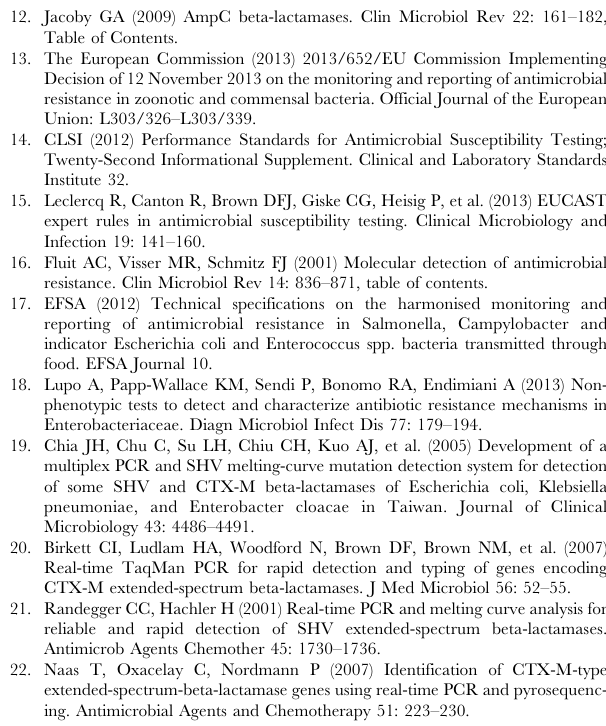
Detected beta-lactamase